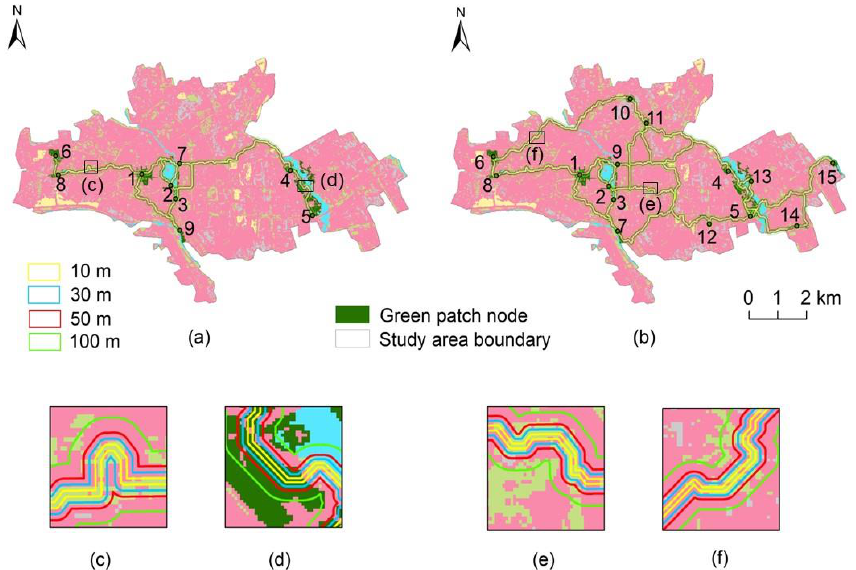
Figure 8. Potential green space networks based on buffers of different distances: (a) recreational